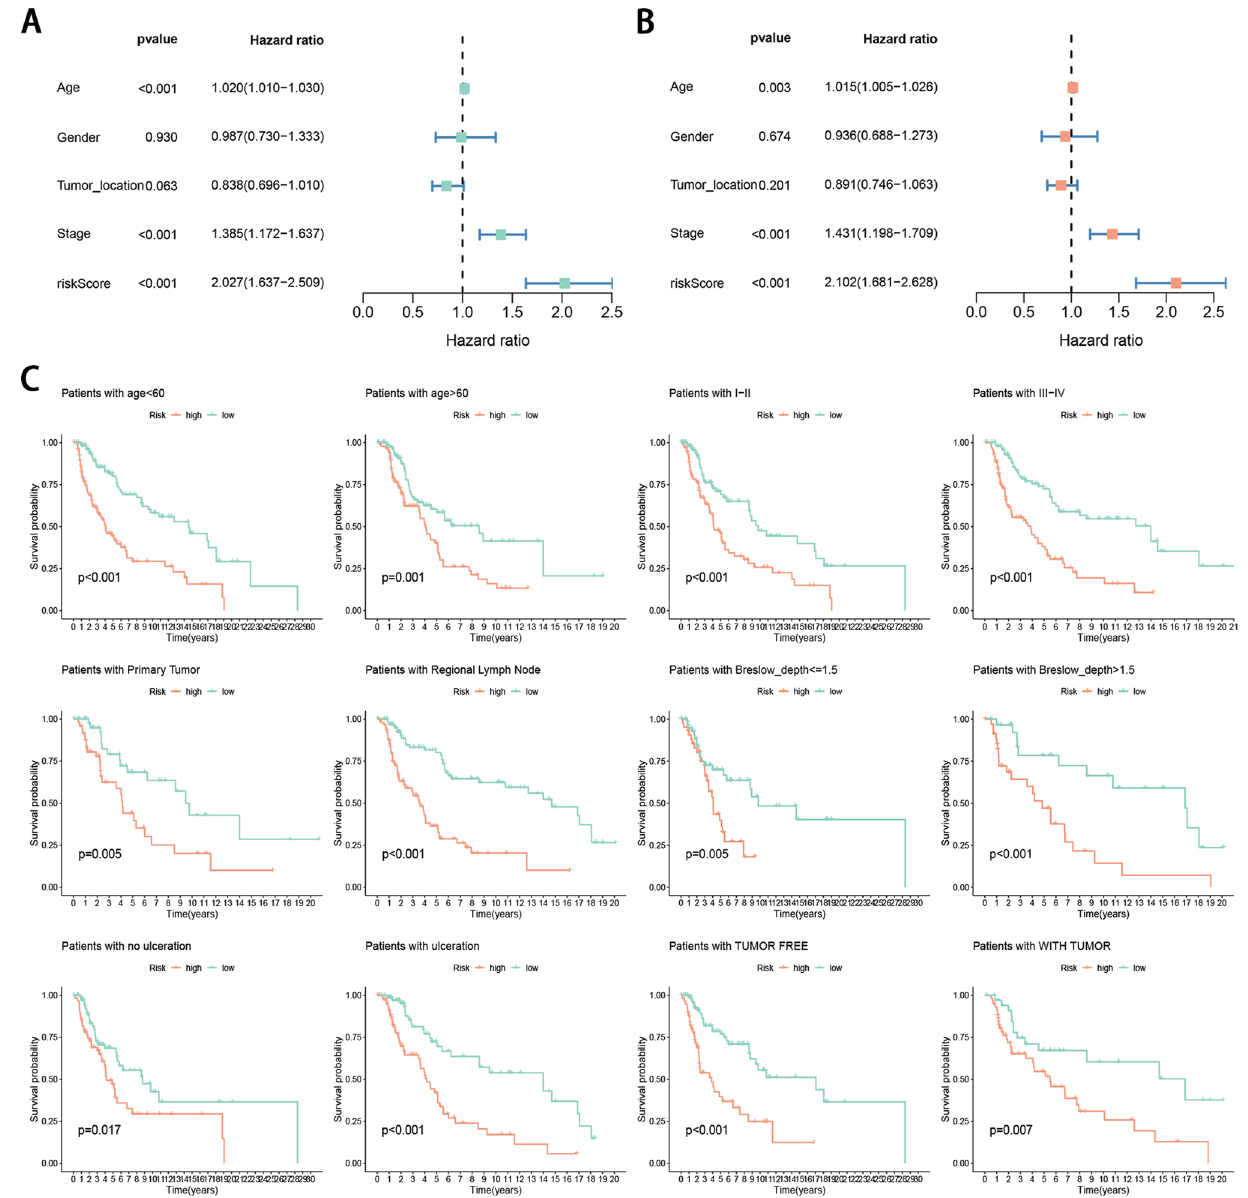
Figure 6. Univariate and multivariate Cox proportional hazards regression analysis for pertinent clinicopathological parameters. ( A ) Higher age, advanced stage, and high-risk groups were significantly poor prognostic factors in univariate analysis. ( B ) The high-risk group remains as an independent poor prognostic factor ( P < 0.05) in the multivariate analysis. ( C ) Survival rates of the high- and low-risk patients in the subgroups based on clinicopathological